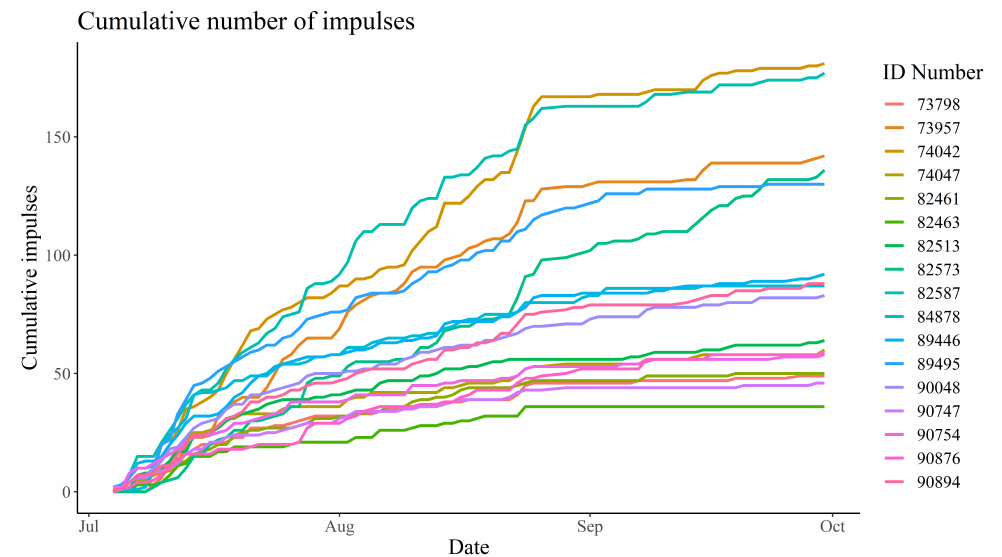
Figure 5. Cumulative number of impulses received by each bull calf between 4 July 2022 and 30 September 2022. The ID Number refers to each of the 17